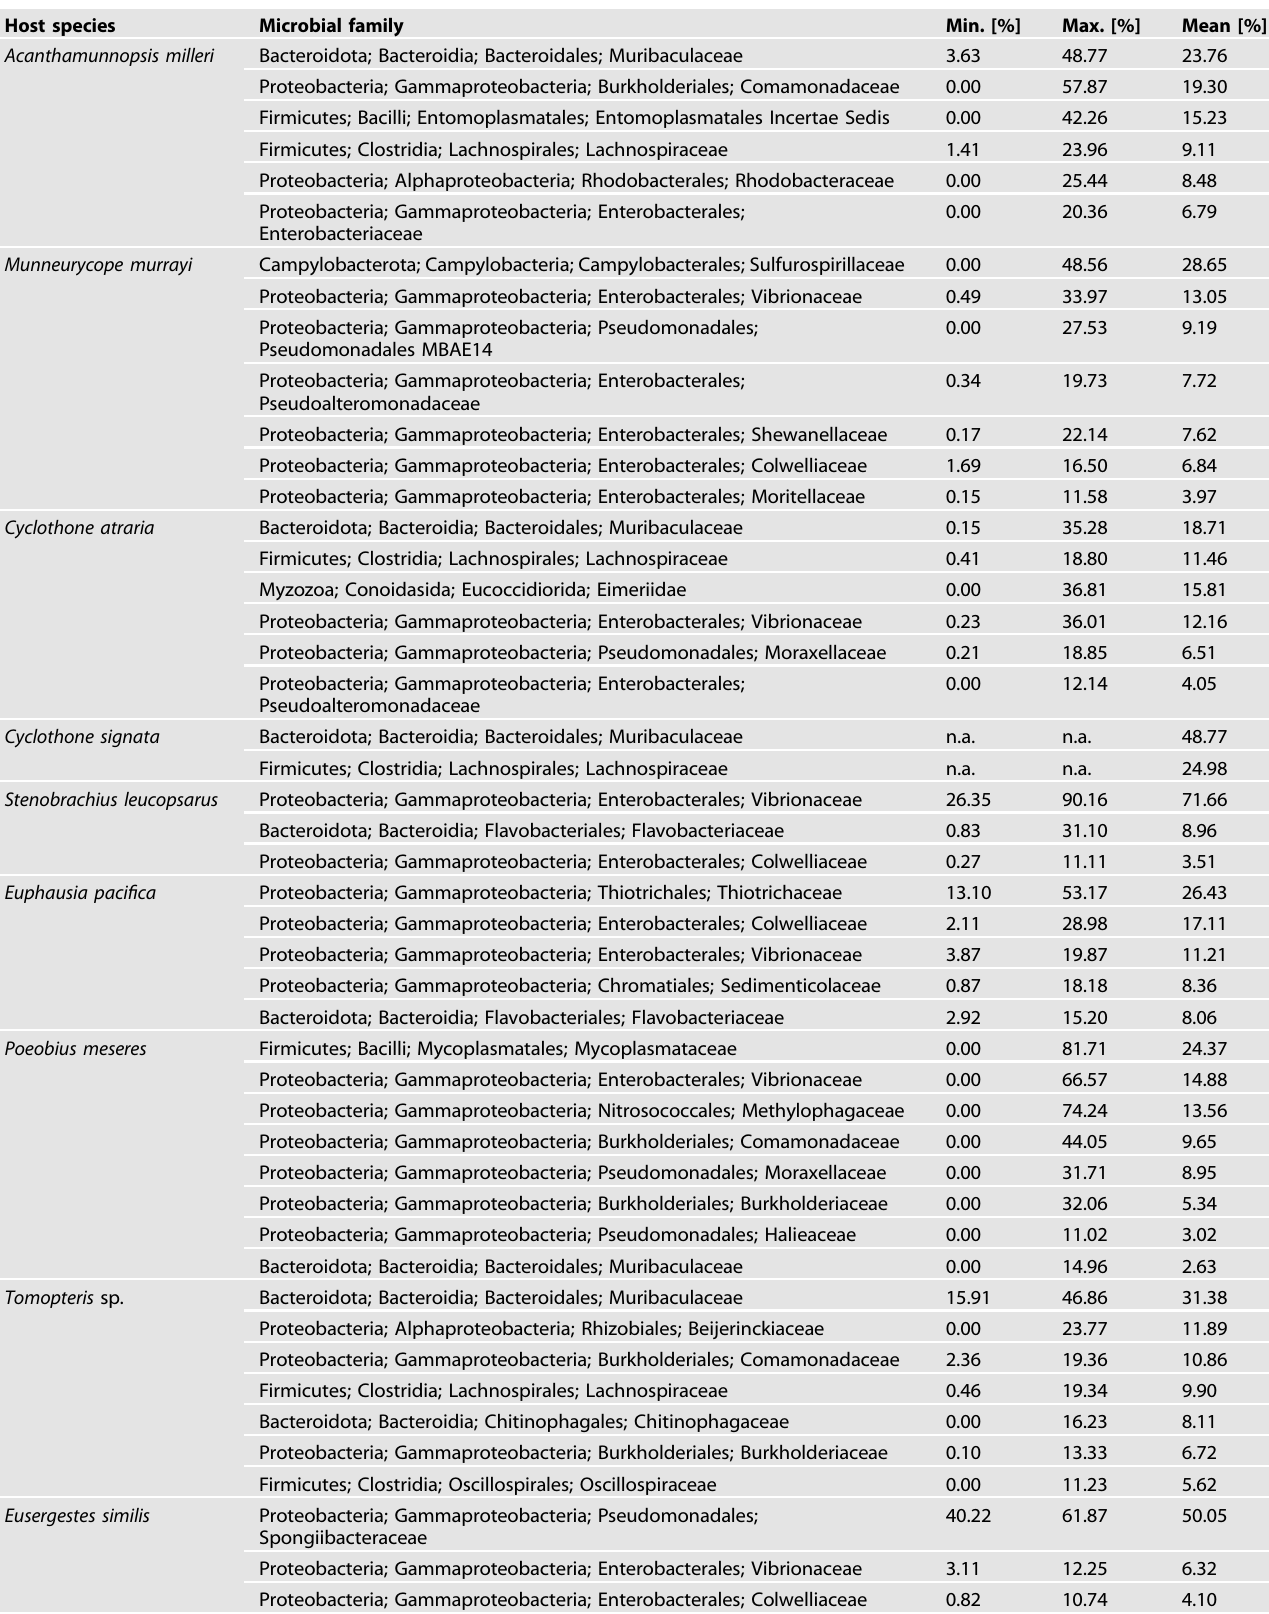
Table 2. Most abundant family-level microbial taxa (>10% in at least one sample) in the microbiomes of mesopelagic invertebrate and fi sh hosts. Host